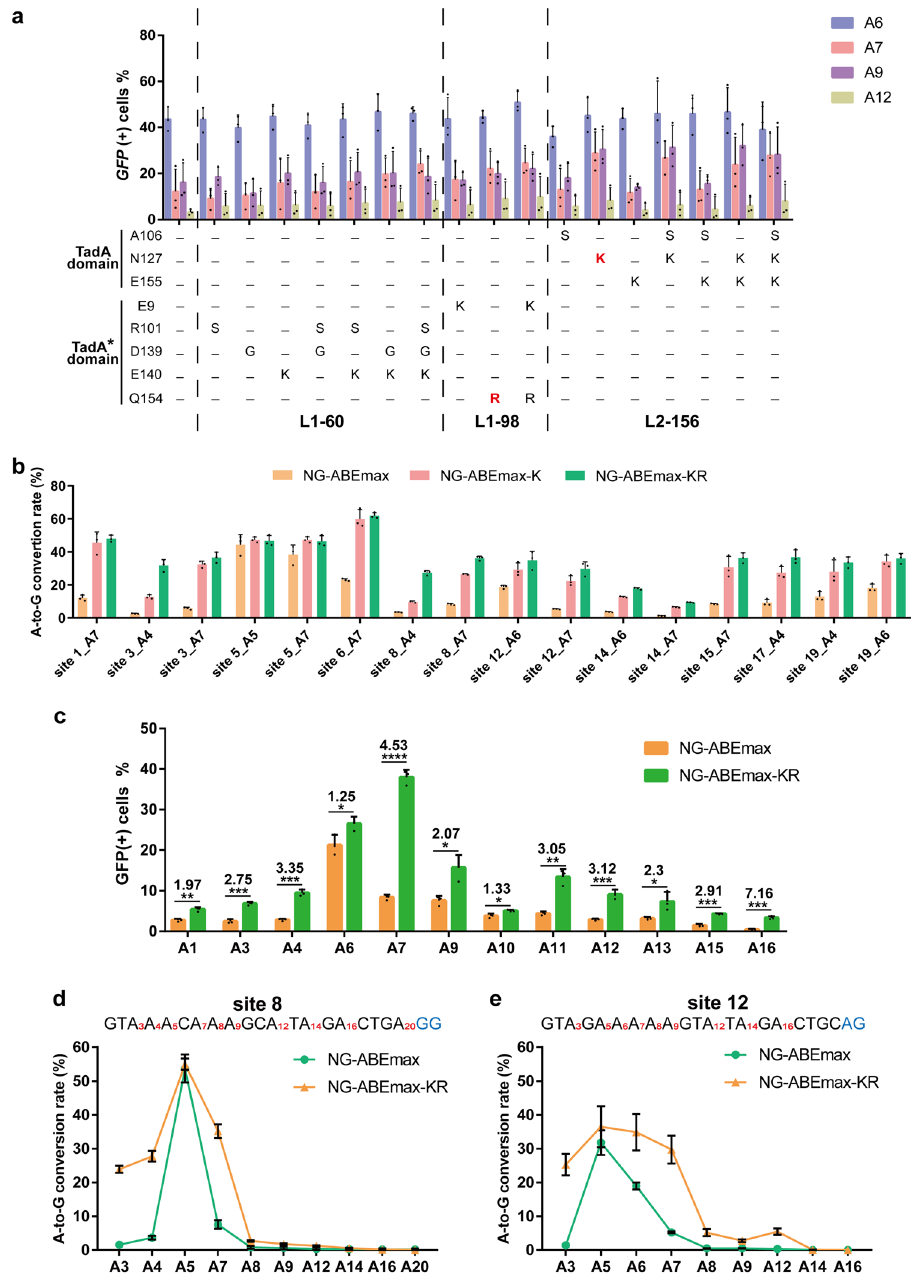
Fig. 3 Engineering of the NG-ABEmax variants. a Mapping the key residues for L1-60, L1-98 and L2-156 using EGFP -based reporter system. Editing ef fi ciencies were quanti fi ed by fl ow cytometry. Error bars indicate mean ± s.d. ( n = 3 independent experiments). b Boosted editing ef fi ciencies of NG- ABEmax-KR at endogenous genomic sites. Error bars indicate mean ± s.d. ( n = 3 independent experiments). c Summary of boosted editing ef fi ciencies of NG-ABEmax-KR at different A base at the EGFP sites. Error bars indicate mean ± s.d. ( n = 3 independent experiments). * P < 0.05, ** P < 0.01, *** P < 0.001, **** P < 0.0001 by Student ’ s unpaired two-sided t test. Exact P value of A1 = 0.002027 (A1 at 0.002027), A3 at 0.000347, A4 at 0.000167, A6 at 0.038443, A7 at 0.000012, A9 at 0.012894, A10 at 0.021788, A11 at 0.001507, A12 at 0.000910, A13 at 0.038361, A15 at 0.000149, A16 at 0.000345. d, e Increased editing window of NG-ABEmax-KR in site 8 and site 10. Each A base was highlighted in red. Error bars indicate mean ± s.d. ( n = 3 independent experiments). Source data are available in the Source data fi